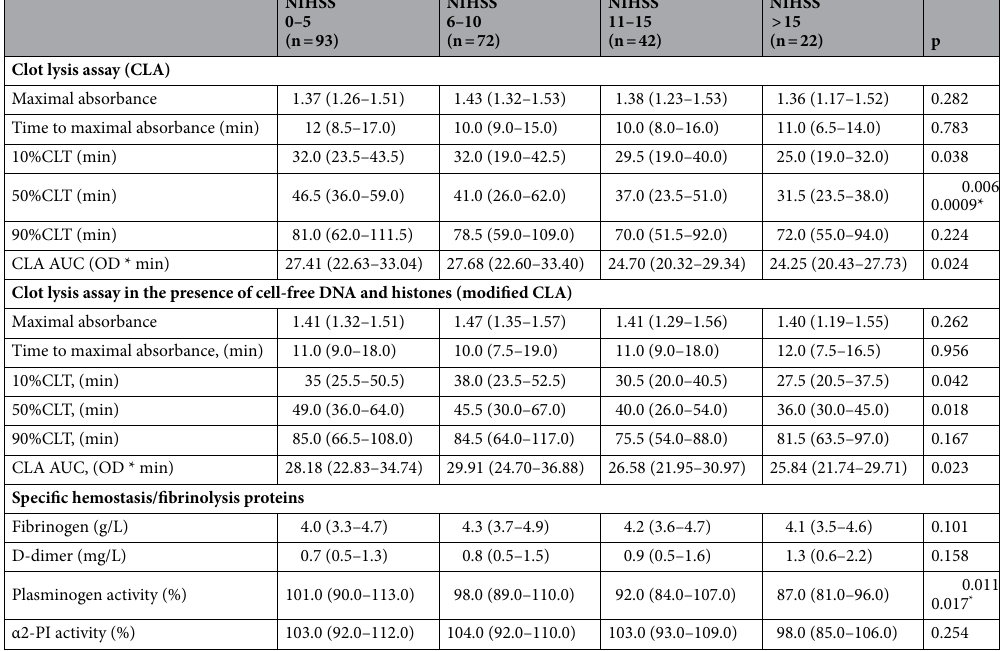
Table 2. Admission clot lysis assay parameters and specific hemostasis/fibrinolysis protein levels according to stroke severity (NIHSS) on admission. Data are medians (interquartile ranges). NIHSS, National Institutes of Health Stroke Scale; 10%CLT, 10% clot-lysis time; 50%CLT, 50% clot-lysis time; 90%CLT, 90% clot-lysis time; CLA AUC, clot lysis assay area under the curve; *NIHSS 0–5 vs. NIHSS > 15 (Kruskal–Wallis with Dunn- Bonferroni post-hoc test). Baseline NIHSS was not available in case of 2 patients.